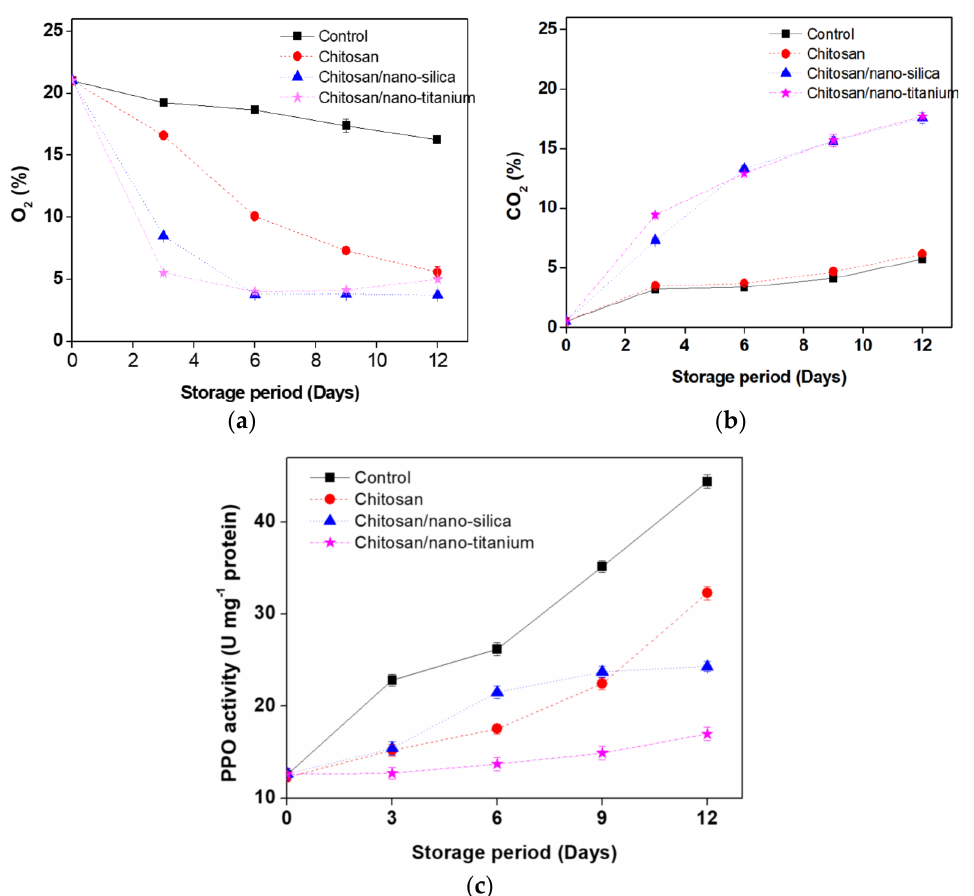
Figure 4. Effects of nano-films on headspace gas as compositions O 2 concentrations ( a ), CO 2 concentrations ( b ), and PPO activity ( c ) for white button mushrooms during storage at 4 ◦ C for 12 days. Data are mean ± SD, n =